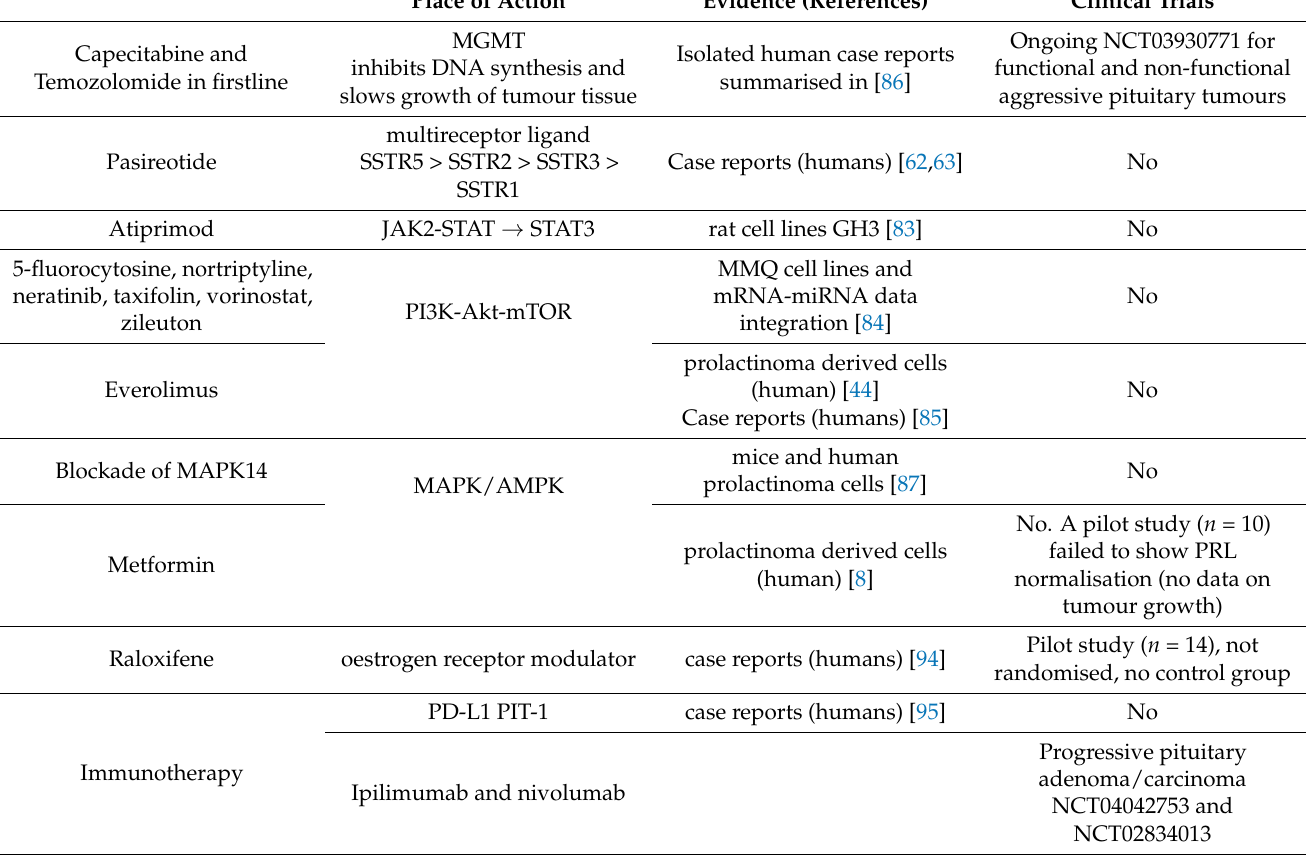
Table 1. Future therapeutic options for aggressive prolactinoma based on the available evidence. Place of